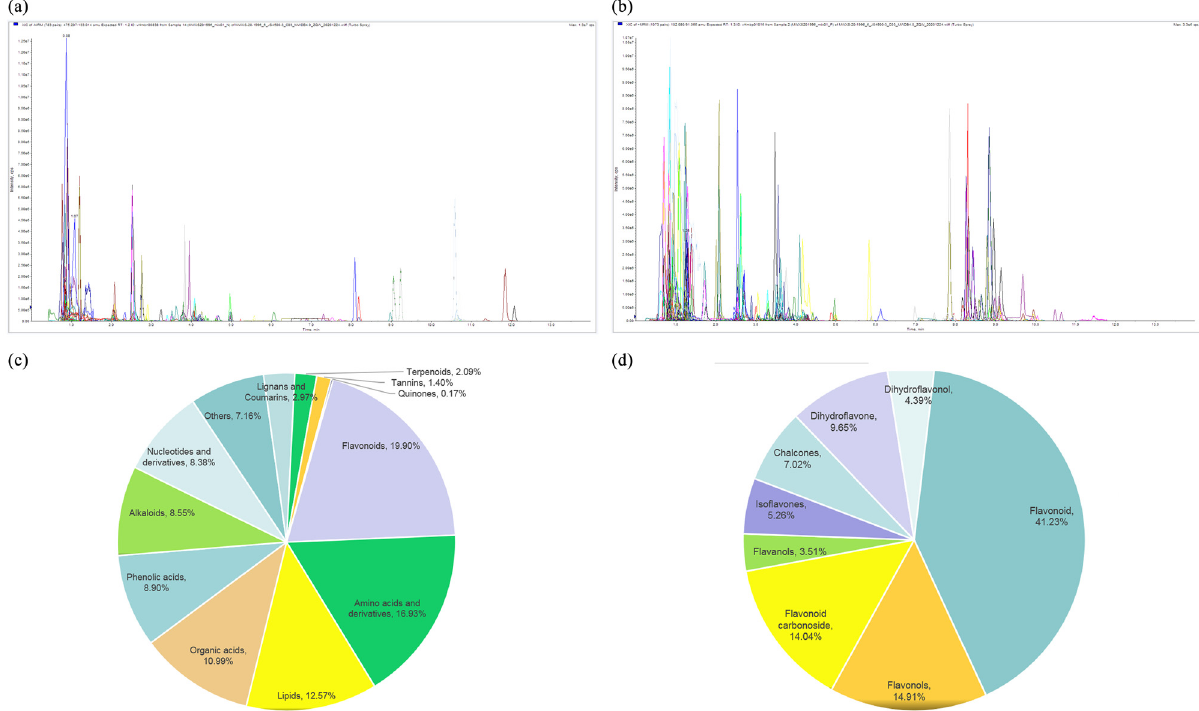
Figure 1: Qualitative and semi - quantitative analysis of the metabolites in Pin.t and XPin.t. The multi - peak mass spectral chromatogram of the metabolites acquired in the negative - ion mode ( a ) and positive - ion mode ( b ) . ( c ) The types and proportions of the identi fi ed metabolites in Pin.t and XPin.t. ( d ) The types and proportions of fl